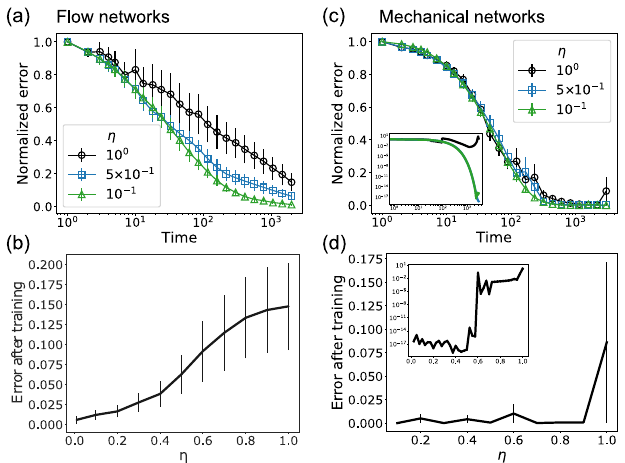
FIG. 8. Effects of nudge amplitude η on learning. (a) 512 node flow networks trained with 10 random source nodes and 3 target nodes. As the nudge amplitude η is increased, training gradually and continuously becomes slower. (b) Trained flow networks (after 2 × 10 3 time steps) perform better if trained with small nudges. (c) When learning is attempted in nonlinear mechanical networks using the l rule, a similar picture emerges on average , where learning degrades at higher η . Moreover, at particular realizations, we observe noncontinuous degradation of the learning process at particular values of η (inset). (d) On average, learning performance is largely maintained until η ∼ 1 . In one 512 node network, trained with 10 random sources and 3 random targets, training is relatively stable until η ≈ 0 . 6 , and then goes thorough a discontinuous jump (inset). Averaged data results from 17 realizations of learning